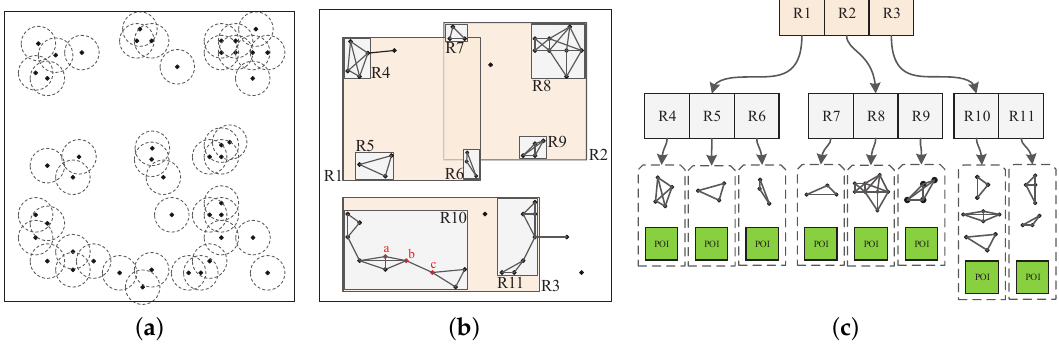
Figure 2. The basic idea of our approach. ( a ) AP spatial distribution and their signal coverage area; ( b ) undigraph G ; ( c ) R-tree T of the clique